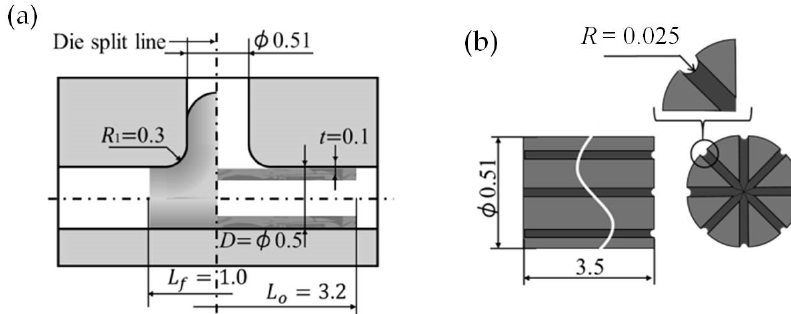
Figure 2. Geometry and dimensions of die and axial punch used for a microtube hydroforming